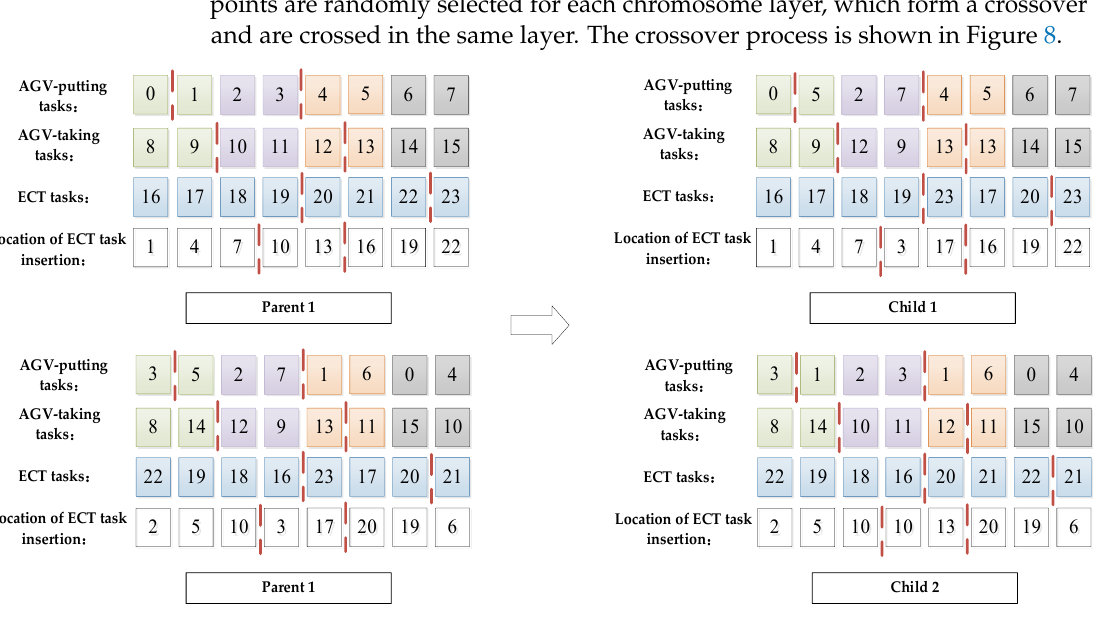
11 15 10 Location of ECT task insertion ： ECT tasks ： AGV-putting tasks ： AGV-taking tasks ： Figure 9. Mutate the task sequence.